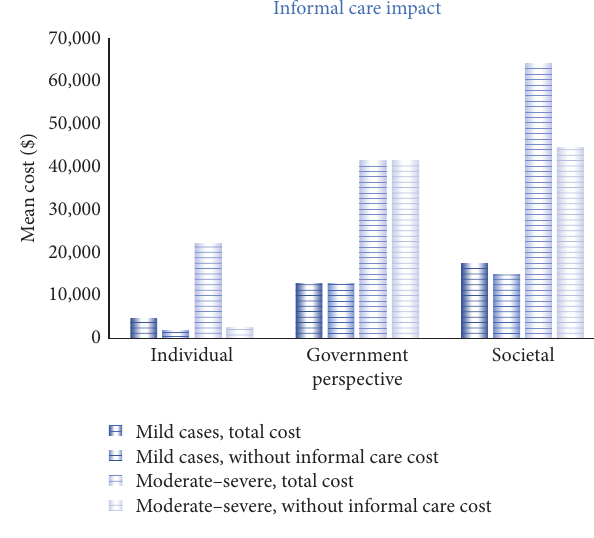
Figure 3: Cost impact of informal